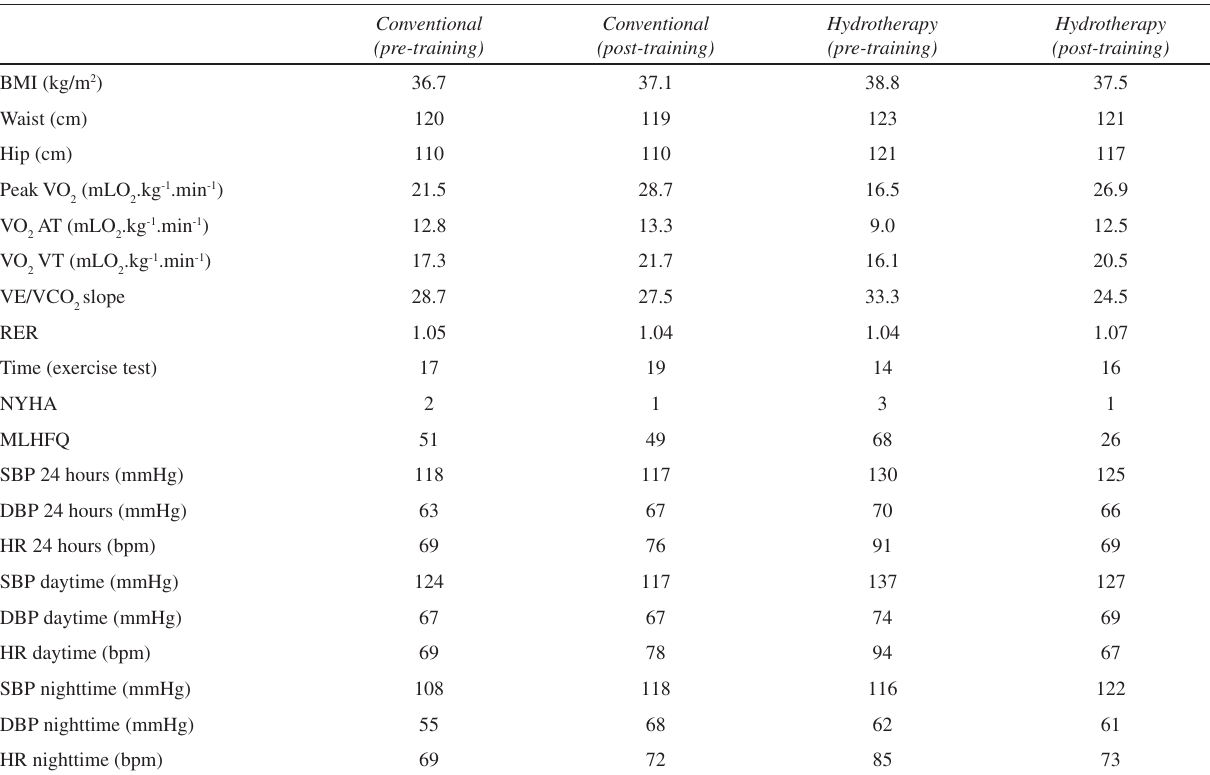
Table 1 - Patient data before and after exercise training